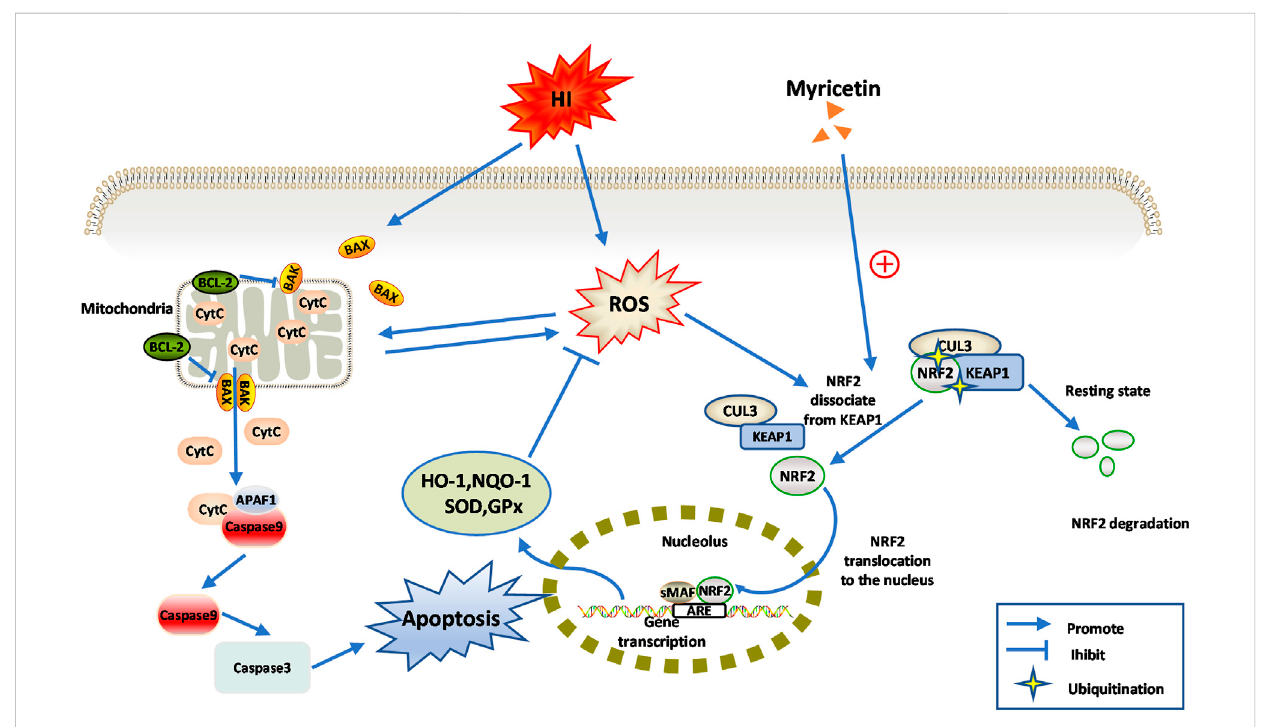
FIGURE 9 Diagram of the potential mechanisms involved the neuroprotective effects of myricetin against HI-induced brain injury or CoCl 2 induced PC12 injury.